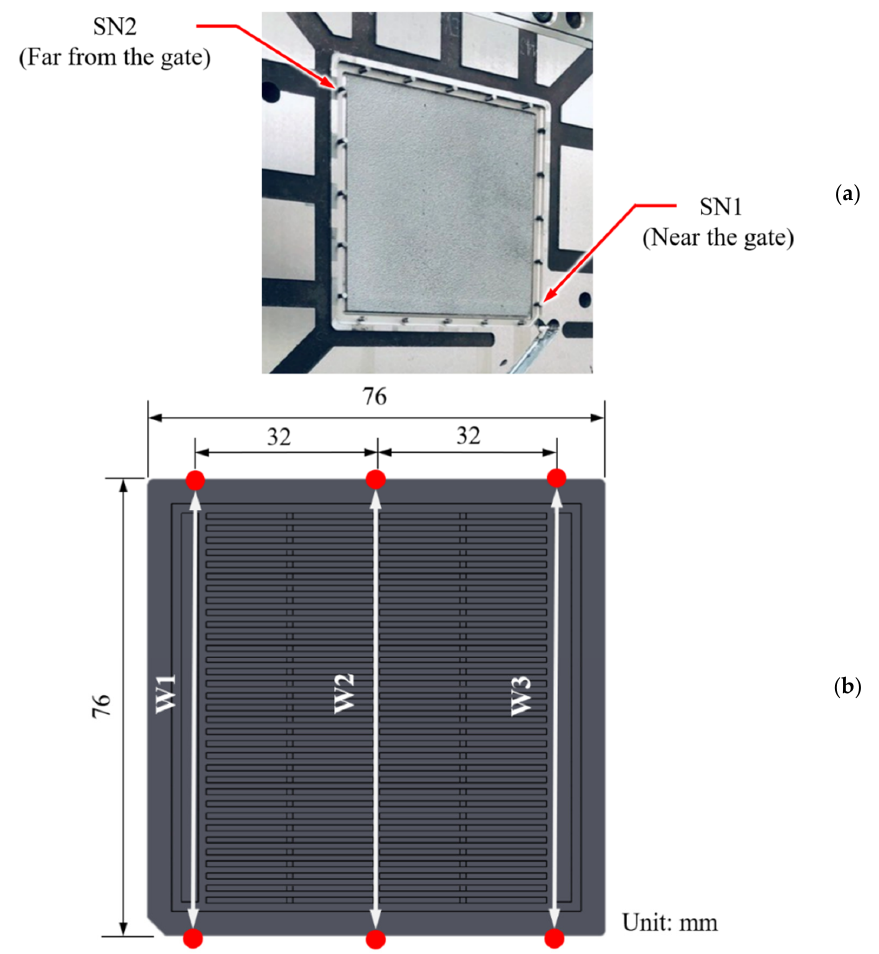
Figure 3. Positions of ( a ) pressure sensors and ( b ) part widths measured by coordinate measuring machine.